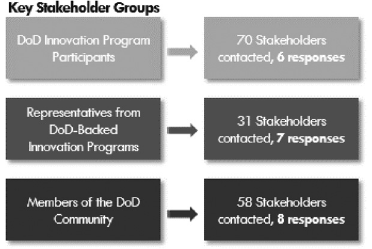
Figure 7. Survey